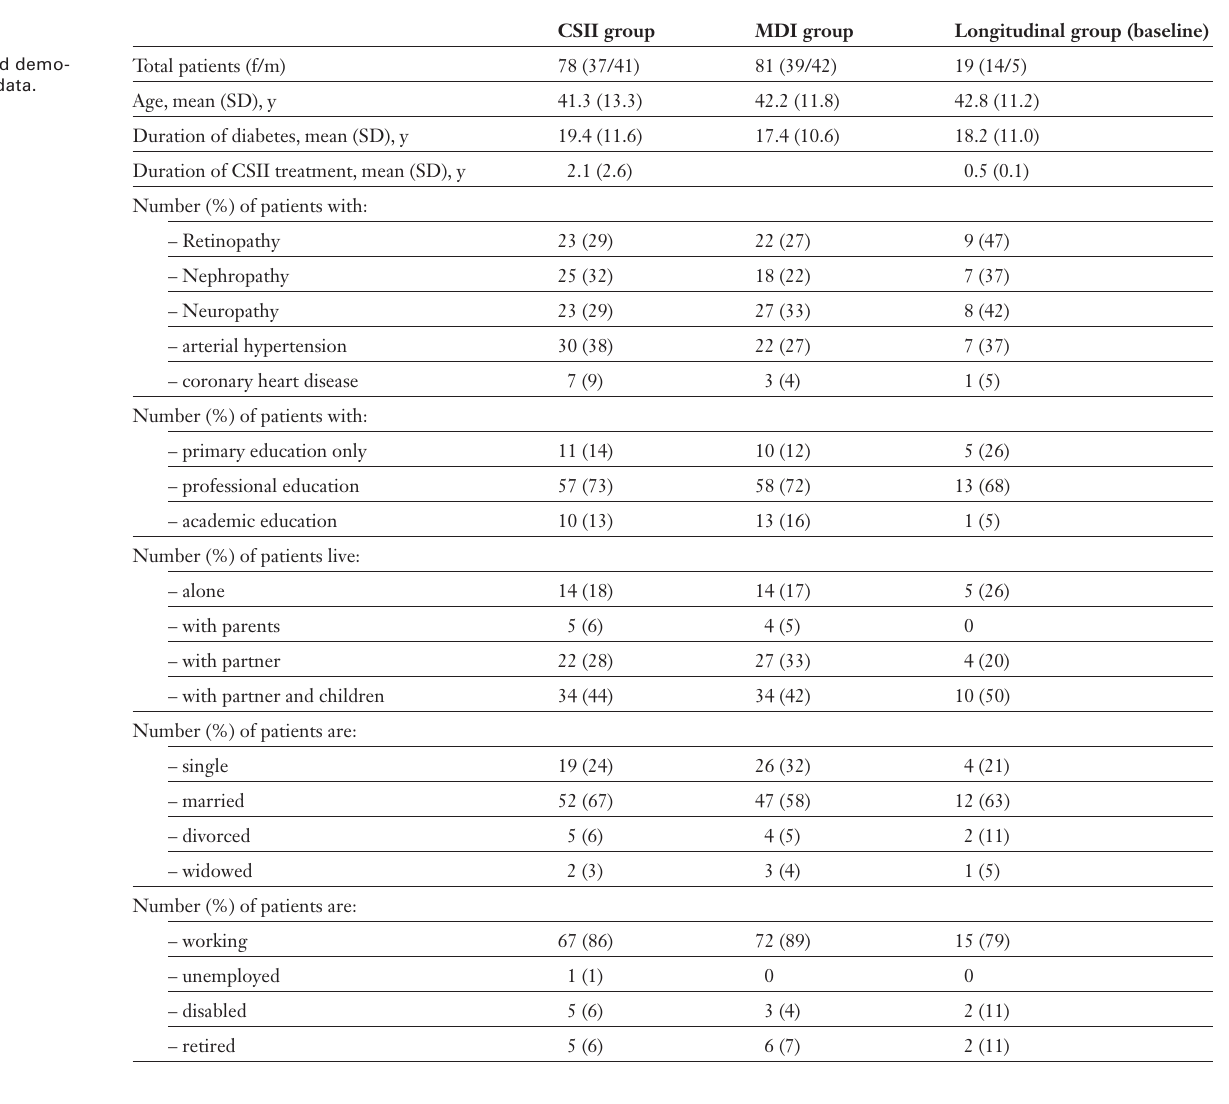
Clinical and demo- graphical data.